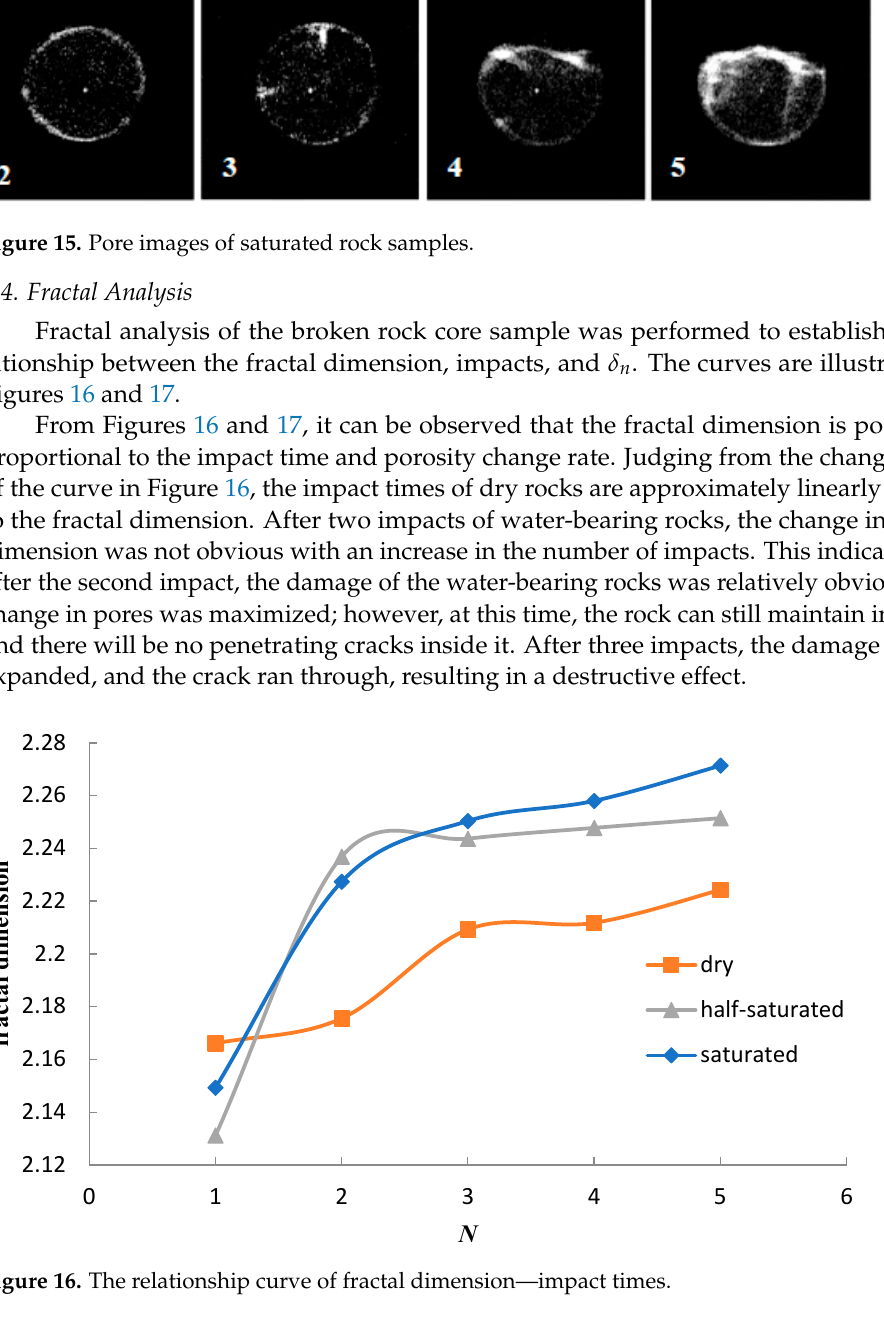
Figure 17. The relationship curve of fractal dimension— δ n . 5. Conclusions To study the mechanical response and damage evolution of rocks under cyclic dy ‐ namic loading and different moisture contents, as well as reduce or even eliminate the effects of other factors; dry, semi ‐ saturated, and saturated sandstone specimens with different moisture contents were prepared via drying, water treatment, and maintenance. The SHPB system was utilized to perform five impact cycles on each rock sample, and an NMR system was employed to scan the rock samples after impact. A small energy impact was utilized in the test because it did not cause serious damage to the sample, which is also similar to real engineering. Compared with references [13,14,16] using an acoustic method to measure rock damage, NMR technology in this study can obtain the changes in rock pores intuitively; therefore, we can master the damage development law. Com ‐